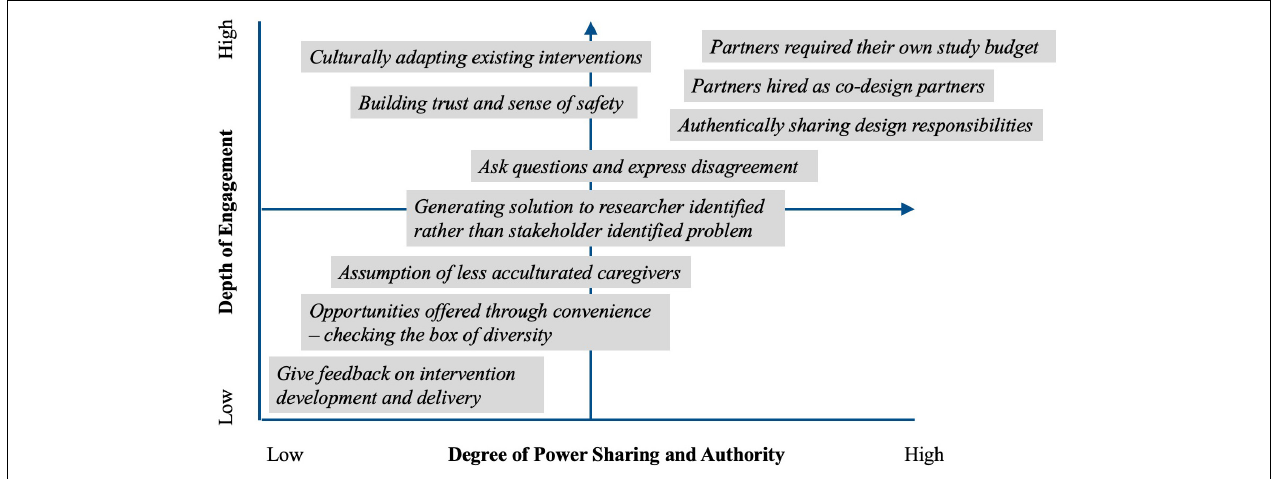
FIGURE 1 | Data from analysis of researcher reflections is used to illustrate a continuum of co-design frameworks that represent (1) the variety of roles for co-design partners and (2) growth as researchers as well as growth in the field toward more authentic and empowered partnerships. These specific examples from the duoethnography analysis are also meant to be used by the reader to reflect and situate their own co-design experiences within this